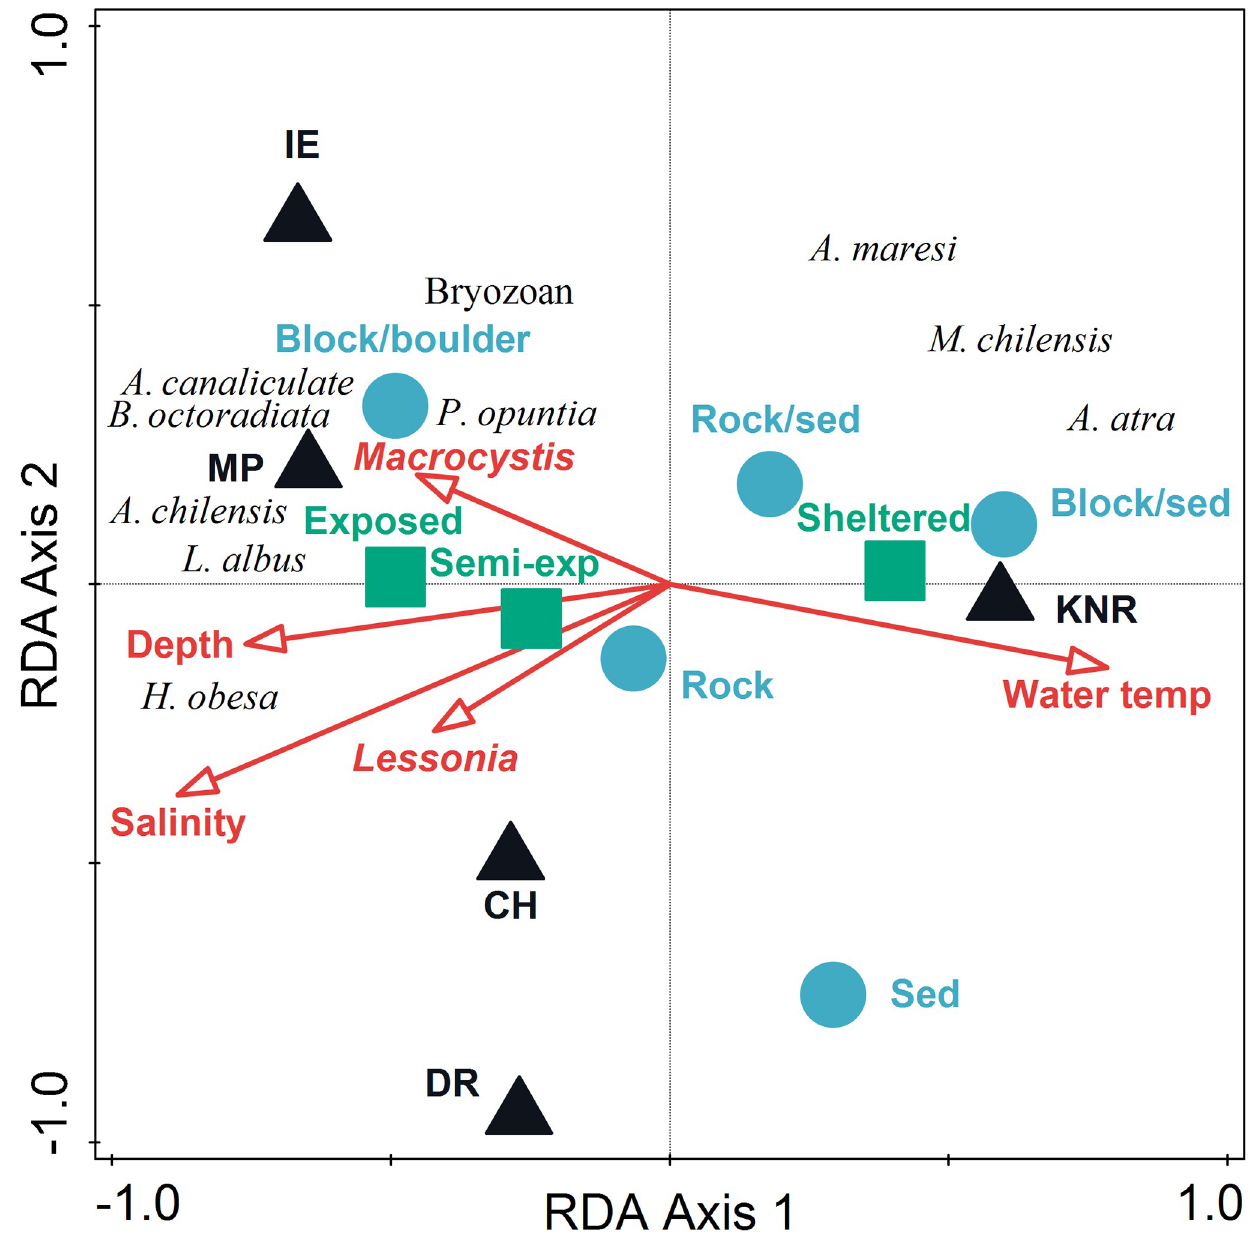
Fig 5. Triplot of results of redundancy analysis on benthic taxa abundance by region with biotic and abiotic variables (depth, salinity, temperature, habitat type, densities of Macrocystis and Lessonia kelp). Data were centered and ln(x+1) transformed benthic taxa abundance by transect. Biotic and abiotic variables were standardized prior to analysis. Taxa codes are as follows: A . chilensis = Actinostola chilensis , A . atra = Aulacomya atra , A . maresi = Amphimedon maresi , A . canaliculata = Austrocidaris canaliculata , B . laevis = Balanus laevis , B . octoradiata = Bunodactis octoradiata , L . albus = Loxechinus albus , M . chilensis = Mytilus chilensis .